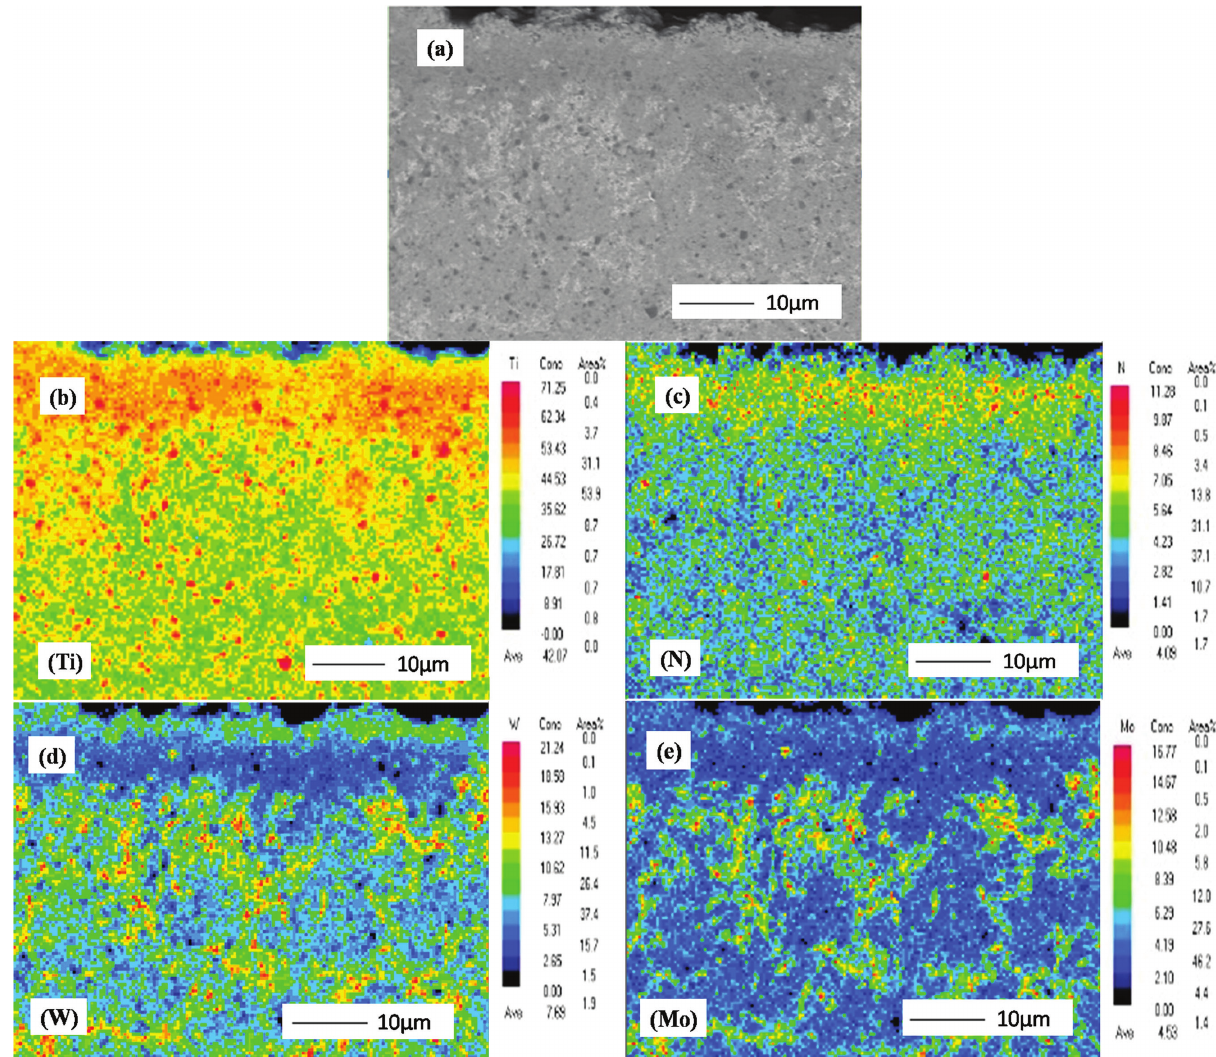
Fig. 1: (a) Micrograph of the cross section and the distribution of the elements, (b) Ti, (c) N, (d) W, (e) Mo in the gradient zone of Ti(C,N) based cermets sintered by microwave